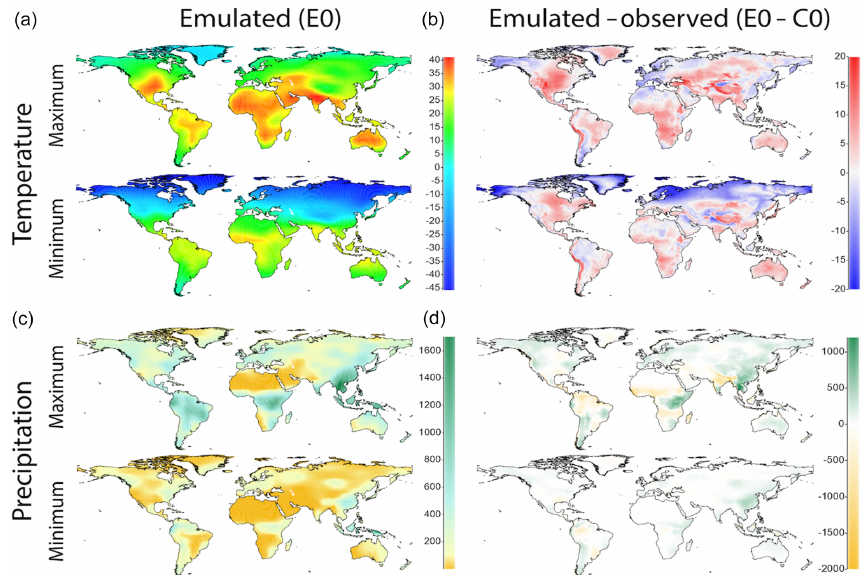
Figure 8. Downscaling the emulated climate. Panels (a) and (c) are the pre-industrial emulations of the seasonal bioclimatic variables at native (T21) model resolution, interpolated into the high-resolution grid. Panels (b) and (d) illustrate the differences with respect to high- resolution climatology (Hijmans et al.,